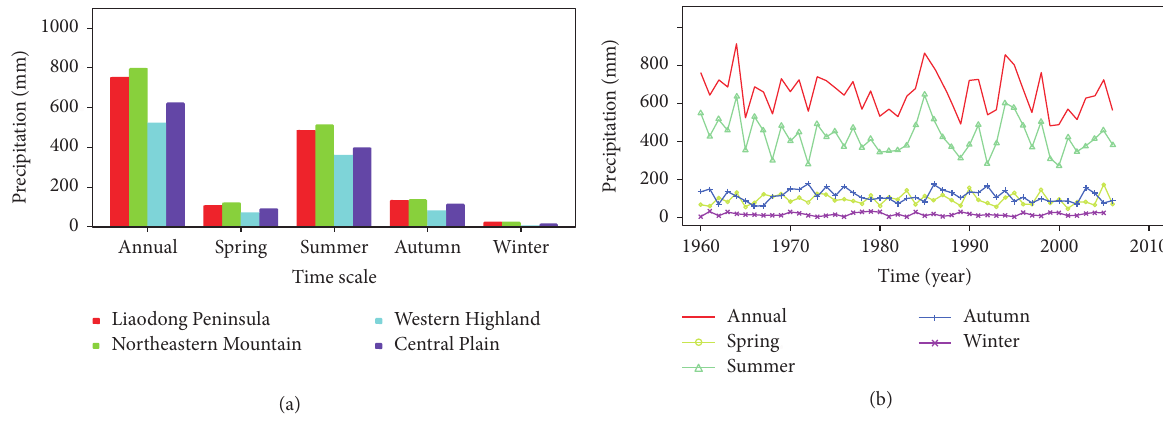
Figure 2: Annual and seasonal precipitation series in Liaoning (a) and mean precipitation for 1960–2006 in different subregions (b).